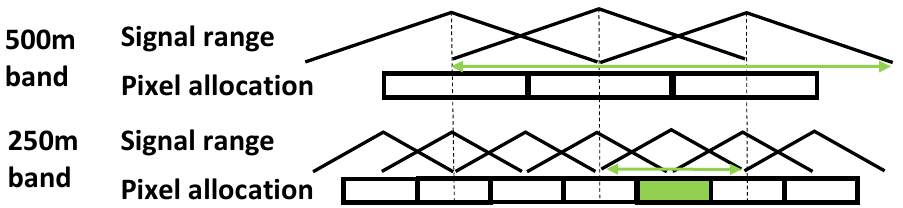
Figure 14. Signal ranges and the nominal pixel allocations of MODIS 250 and 500 m bands at nadir sensor angle.